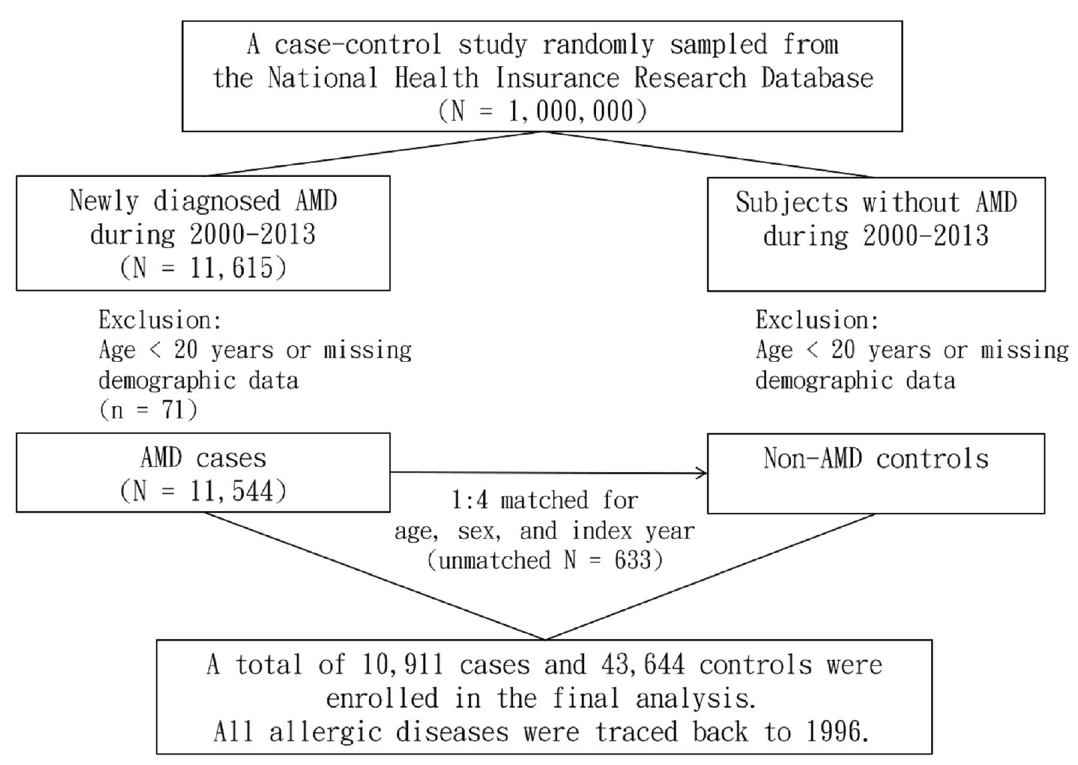
Figure 1. Flowchart of the study